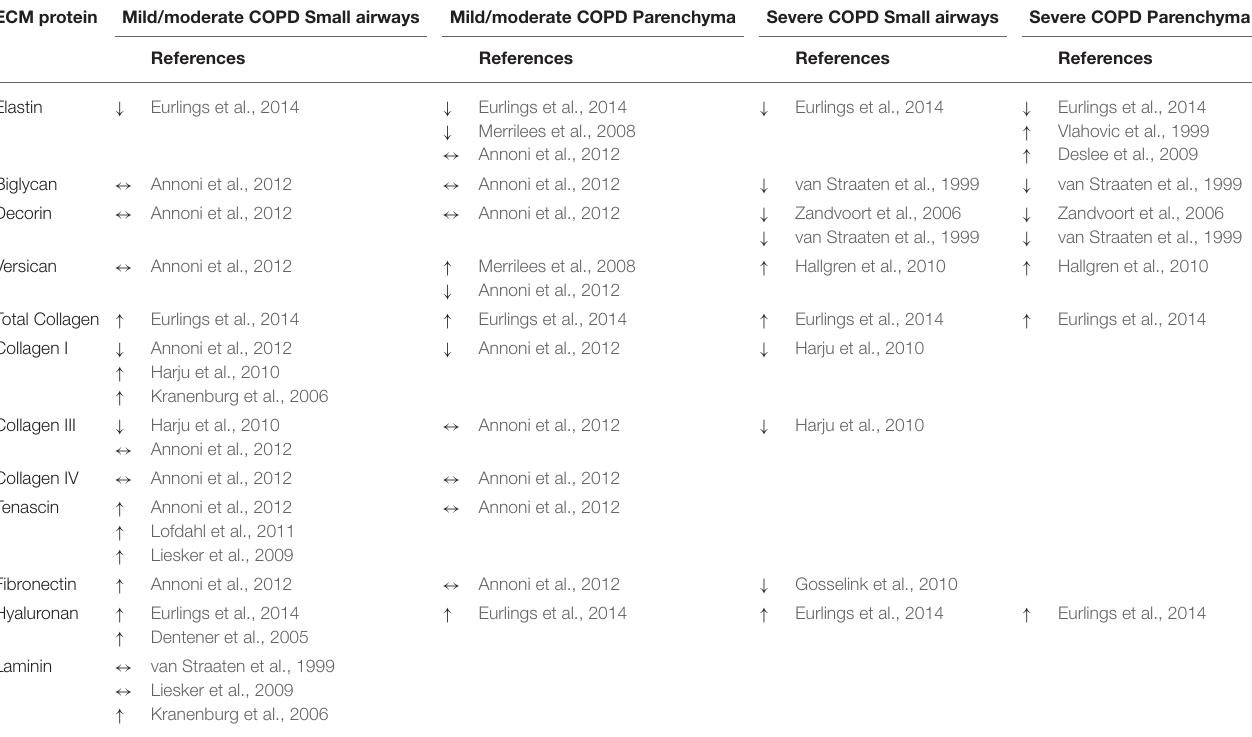
TABLE 1 | Extracellular matrix changes in airways and parenchyma of patients with COPD. ECM protein Mild/moderate COPD Small